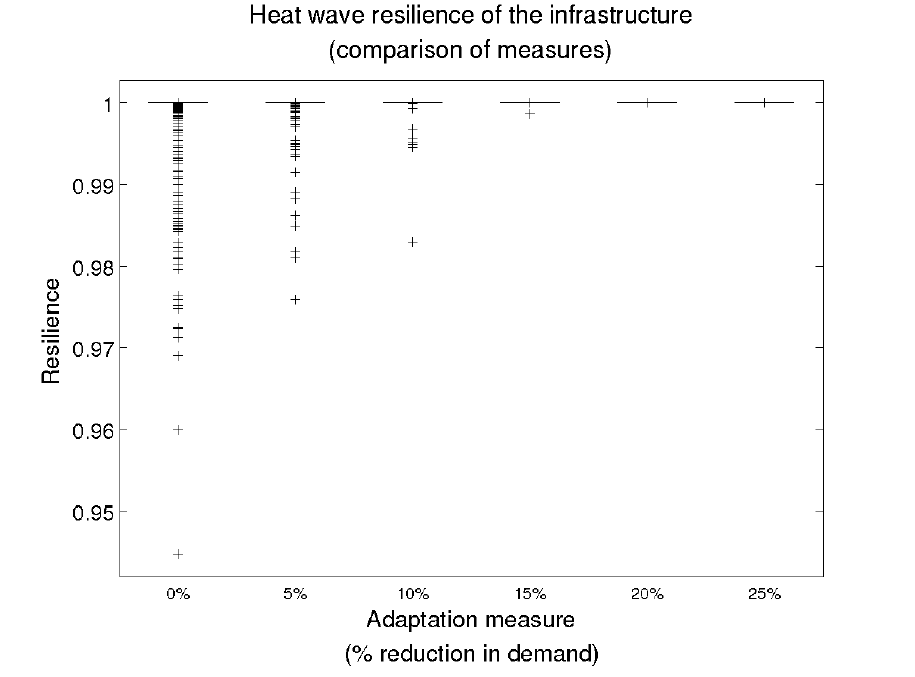
Figure 8. Comparison of resilience values obtained across the tested adaptation scenarios. The ends of the dark box (horizontal line in this case) indicate the 25th and 75th percentiles; outliers are plotted individually as